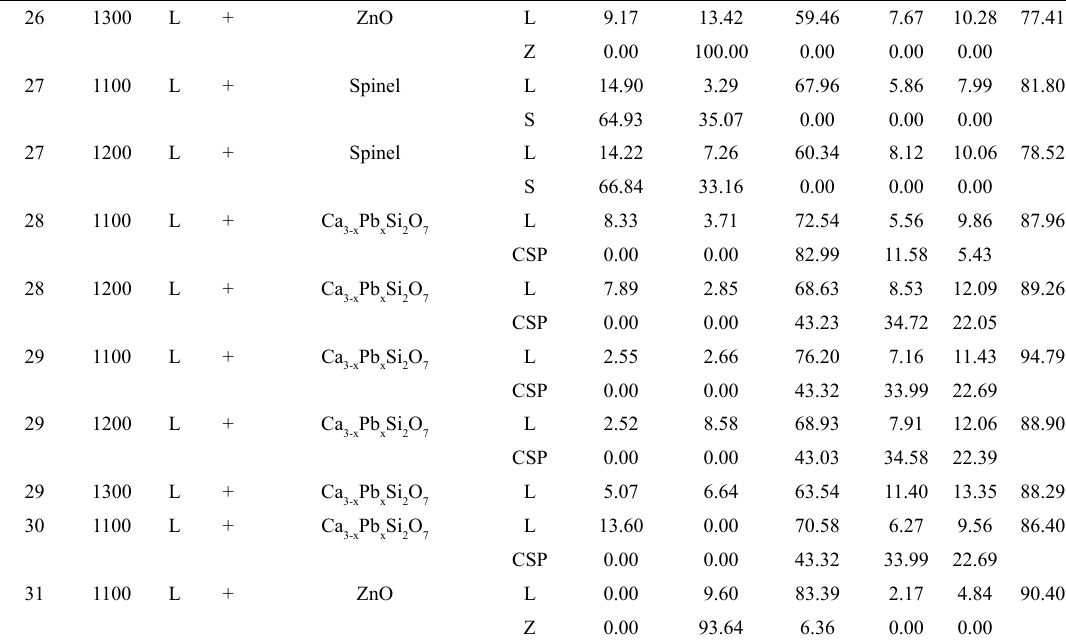
weight ratio of 1.1 and PbO/(CaO+SiO 2